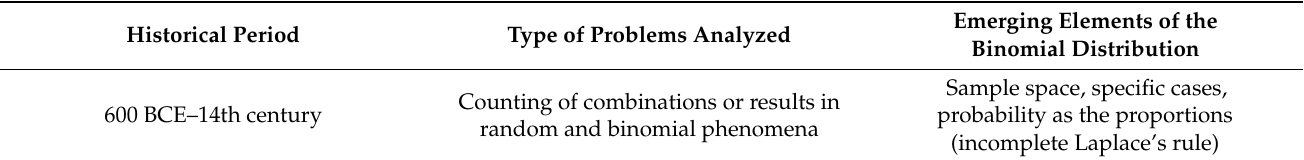
Table 11. Synthesis of historical study, contributions that generated a change in the heuristics, and emerging elements of the binomial